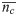
Predictions of population level synergy.(A-F) The predicted population level and overall synergy over a range of drug concentrations (see text for details). (G, H) The predicted overall and population level synergy for varying mean TMPRSS2 expression and fixed mean (nc¯ = 11.5) Cathepsin B/L expression (G) and for varying mean Cathepsin B/L expression and fixed mean (nt¯ = 11.5) TMPRSS2 expression at two different drug concentrations (H). The drug concentrations were normalised by the respective γ values. In A-C and G-H, nt50 = 1.2 x 105 copies/cell and nc50 = 2.4 x 105 copies/cell. In D-F, nt50 = 4 x 104 copies/cell, nc50 = 4 x 104 copies/cell. In G-H, DT/γT = DC/γC = 10. The parameters are listed in S1 Table.